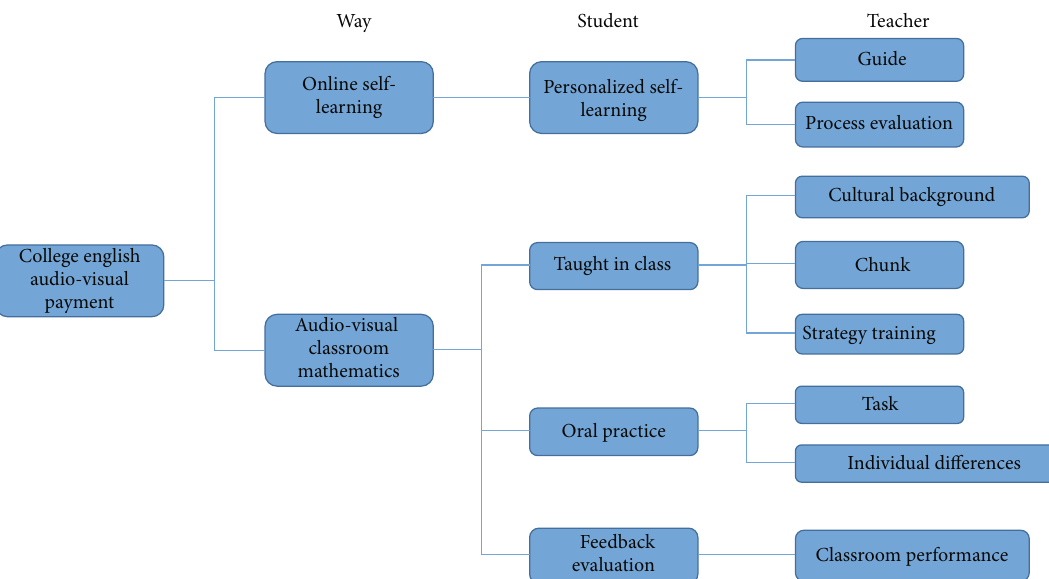
Figure 16: Methodological framework of college English audiovisual speaking teaching.